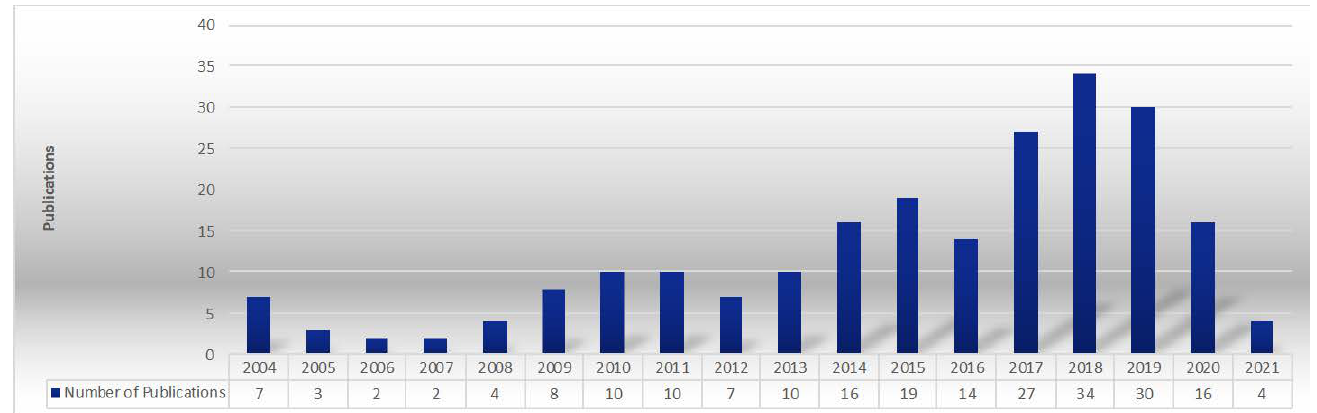
Figure 2. Frequency of 223 reviewed publications per year.